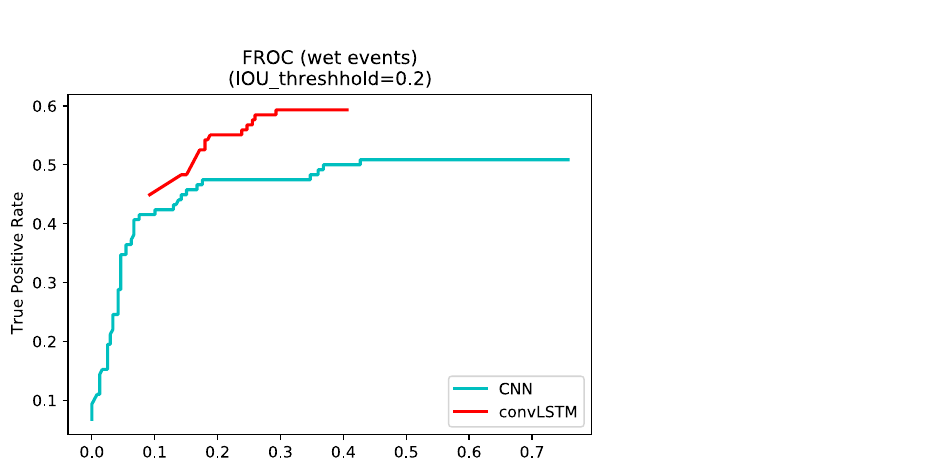
Figure 9. Per-event recall versus average number of FP